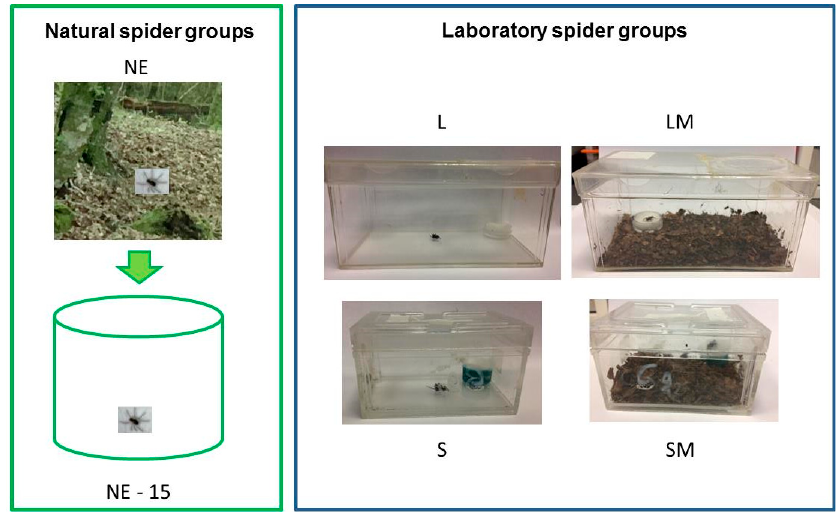
Figure 1. Rearing conditions of adult spiders: developed in natural environment (NE group); wild caught spiders housed in the laboratory for 15 days (NE-15 group); juveniles spiders developed in the laboratory in large terraria without matter on the base until adult (L group); developed in large terraria with matter on the base until adult (LM group); developed in small terraria without matter on the base until adult (S group); developed in small terraria with matter on the base until adult (SM group).